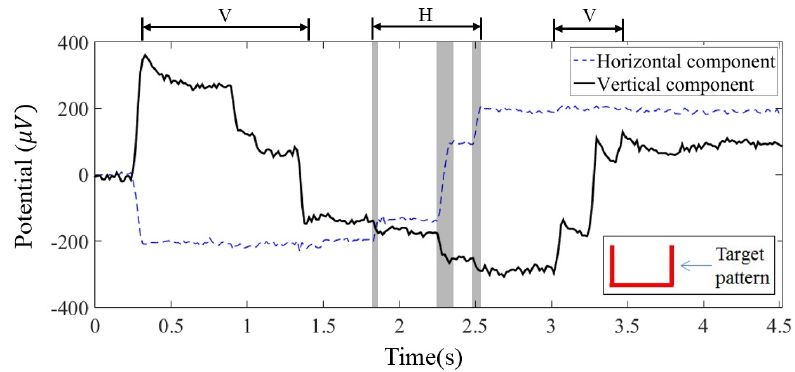
Figure 4. Horizontal and vertical EOG components of a participant. V and H above the graphs denote the time periods of the vertical and horizontal eye movements, respectively. The horizontal axis represents time.